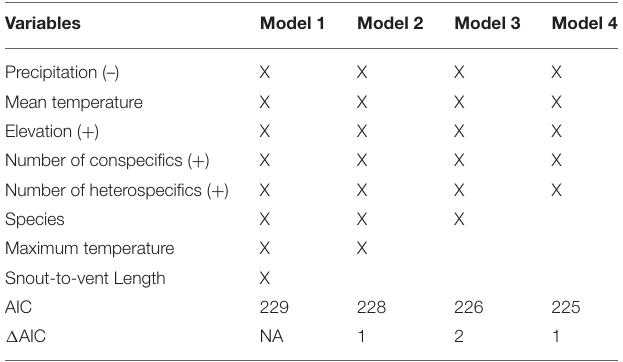
TABLE 3 | Top 4 models of the stepwise binary logistic regression for B. luciae and A. lugubris with Bd infection status as the dependent variable.